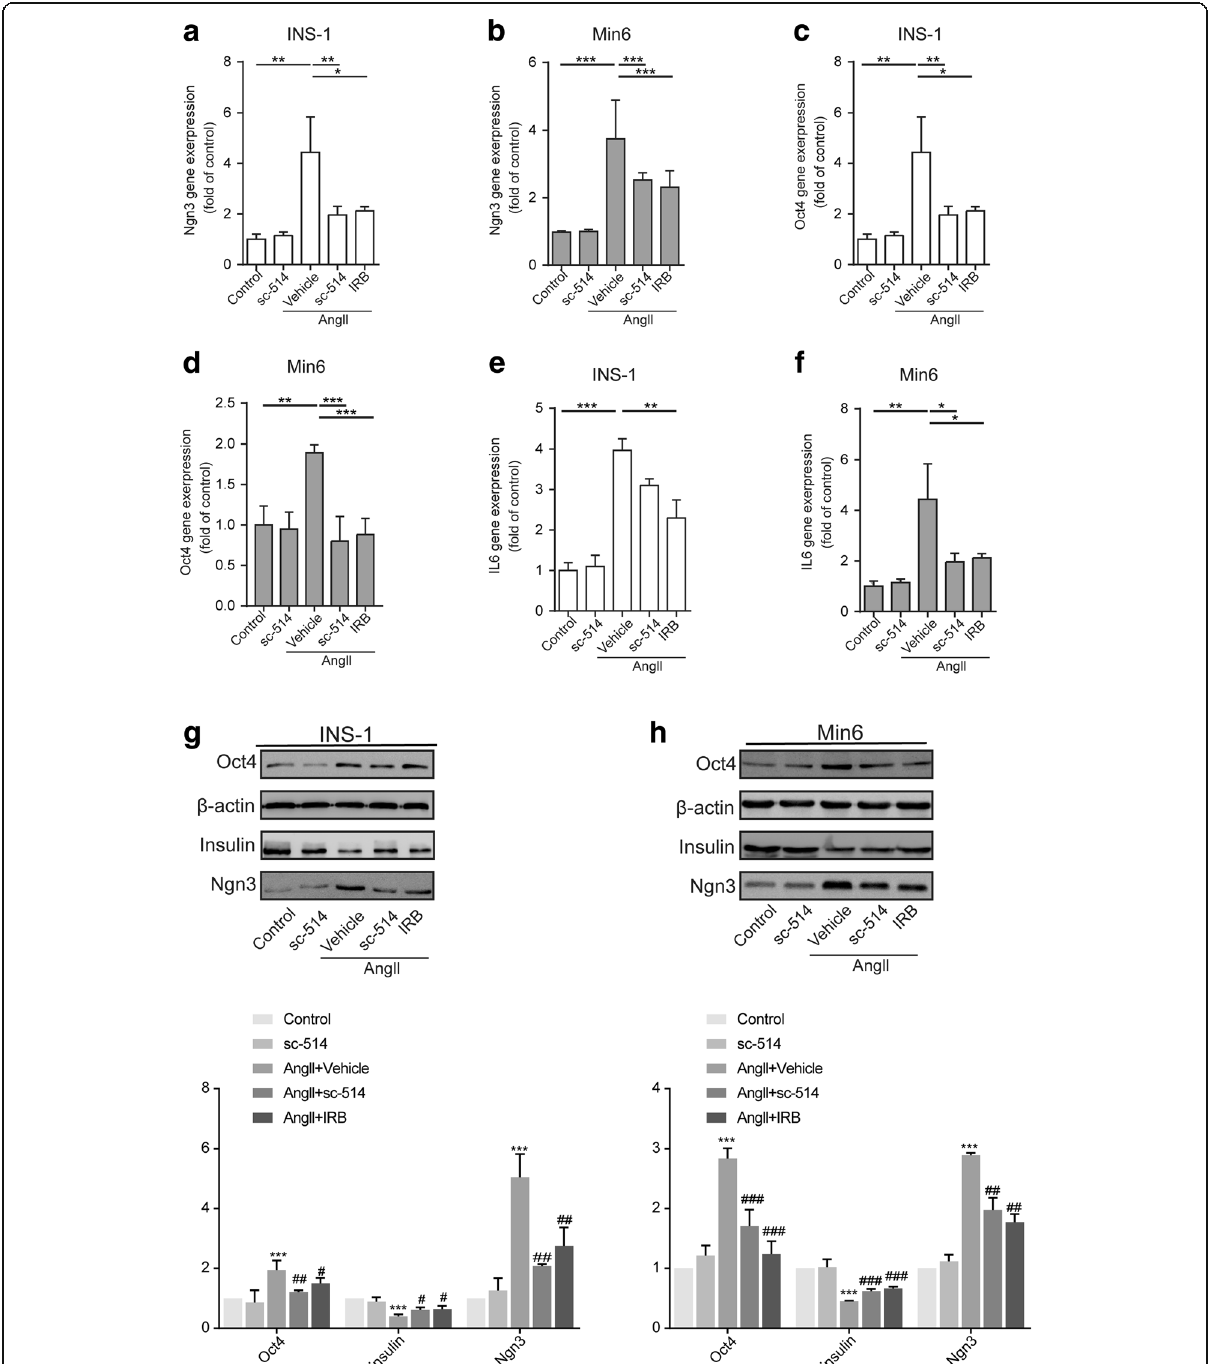
Fig. 2 The deleterious effect of Angll is dependent on NF- κ b signaling in β cells. Pancreatic β cell lines were cultured with or without Angll (1 μ mol/L) in the presence or absence of sc-514, an IkB-kinase-2 inhibitor (20 μ mol/L), or Irbesartan (IRB) (10 μ mol/L) for 48 h. qRT-PCR analyses for ( a-d ) progenitor likes cell markers ( Ngn3 , Oct4 ) and ( e, f ) proinflammatory cytokine Il6 . Data are presented as the mean ± SEM of three independent experiments ( n = 6), * p < 0.05, ** p < 0.01, *** p < 0.001, one-way ANOVA. g, h Western blotting for NGN3, OCT4, and insulin in Min6 cells and INS-1 cells. β -actin was used as a loading control. Densitometric analyses of the western blotting results are presented below. Data are presented as the mean±SEM of three independent experiments( n =6). ** p <0.01, *** p <0.001 vs Control group, # p <0.05, ## p <0.01, ### p <0.001 vs Vehicle group, one-way